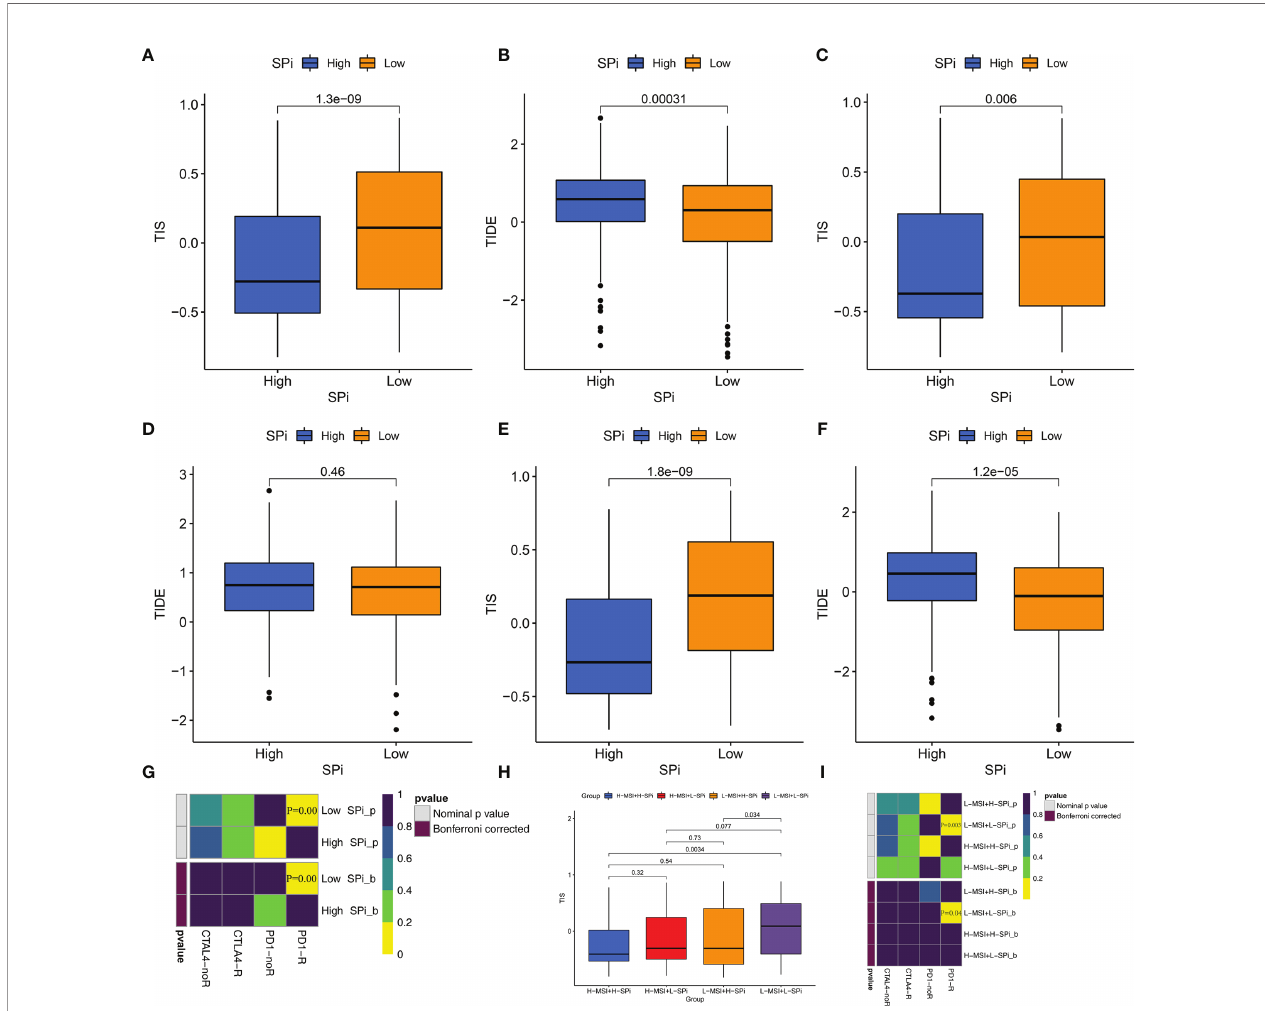
FIGURE 8 | Patients with low stemness could bene fi t from immunotherapy. The differences of TIS and TIDE between patients with high and low SPi in the overall cohort (A, B) , TCGA-SARC cohort (C, D) GSE21050 cohort (E, F) . (G) The response of patients with high and low SPi to PD1 and CTLA4 inhibitors (Benjamini and Hochberg corrected p < 0.05). (H) The differences of TIS in patients with high MSI+ high SPi, high MSI +low SPi, low MSI + high SPi, and low MSI + low SPi. (I) The response of patients with high MSI+ high SPi, high MSI +low SPi, low MSI + high SPi, and low MSI + low SPi to PD1 and CTLA4 inhibitors (Benjamini and Hochberg corrected p <